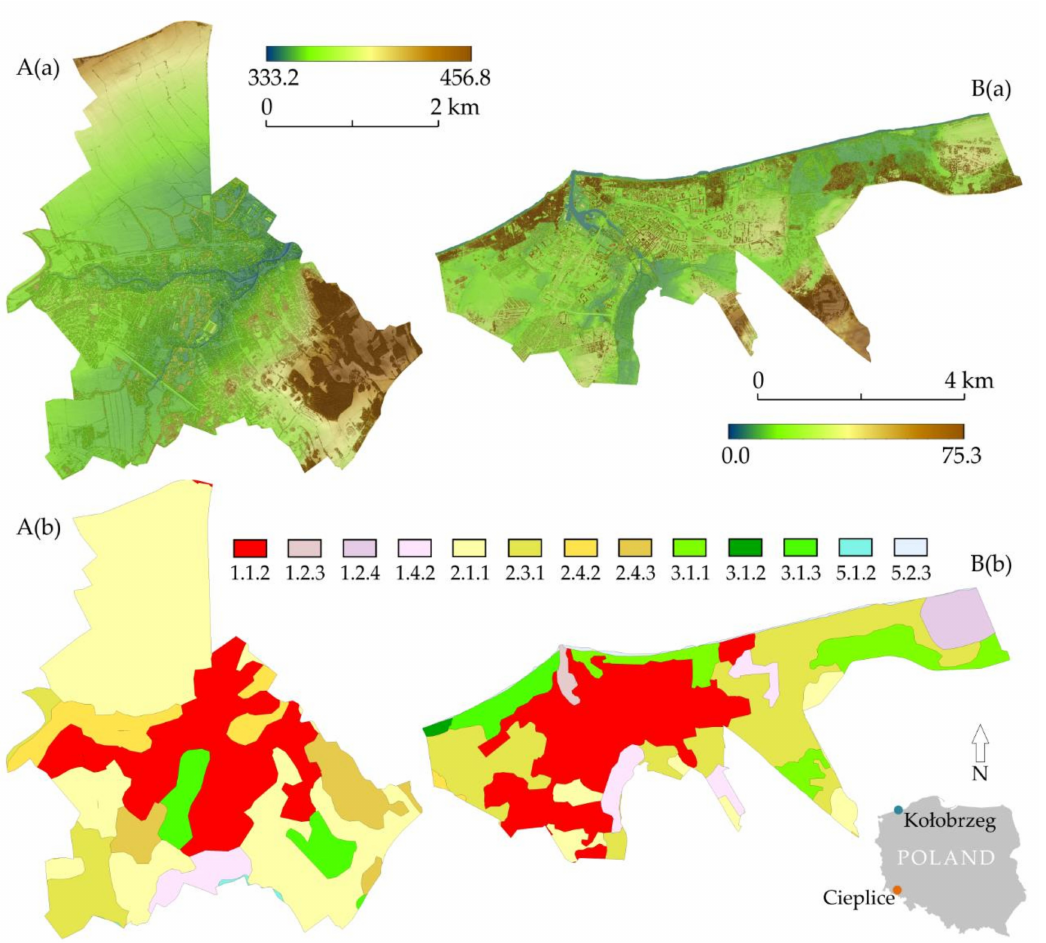
Figure 1. Study area: ( A )—Cieplice, ( B )—Kołobrzeg: ( a ) numerical land cover model, in m a.s.l.; ( b ) CORINE CLC, types: 1.1.2 Discontinuous urban fabric; 1.2.3 Port areas; 1.2.4 Airports; 1.4.2 Sport and leisure facilities; 2.1.1 Non-irrigated arable land; 2.3.1 Pastures; 2.4.2 Complex cultivation patterns; 2.4.3 Land principally occupied by agriculture, with significant areas of natural vegetation; 3.1.1 Broad-leaved forest; 3.1.2 Coniferous forest; 3.1.3 Mixed forest; 5.1.2 Water bodies; 5.2.3 Sea and